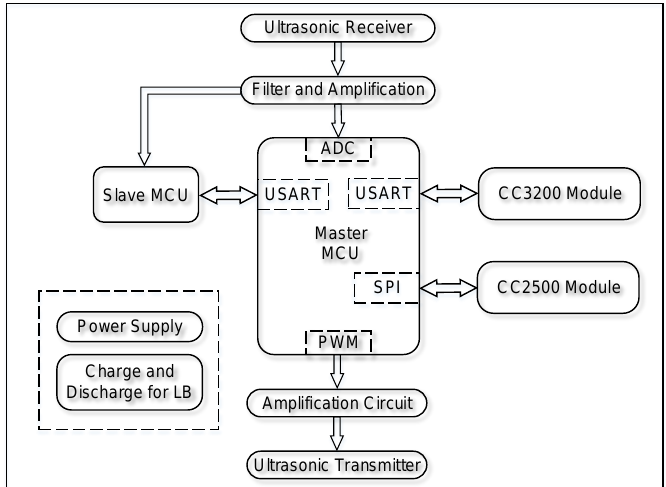
Figure 8. The hardware architecture of the UIPS node. ADC: analog-to-digital converter; LB: lithium battery; MCU: microcontroller unit; PWM: pulse width modulation; SPI: serial peripheral